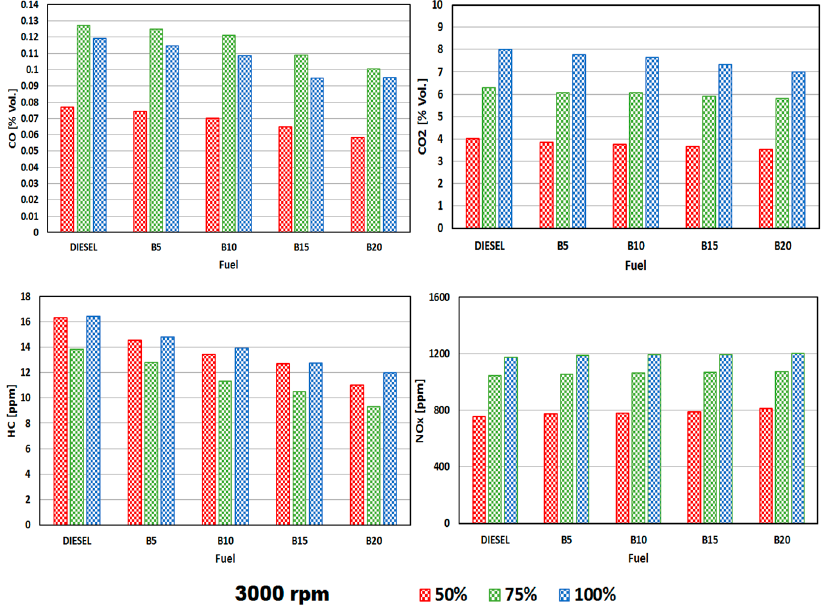
Figure 9. DSO biodiesel engine emission species under three loads and 3000 rpm.